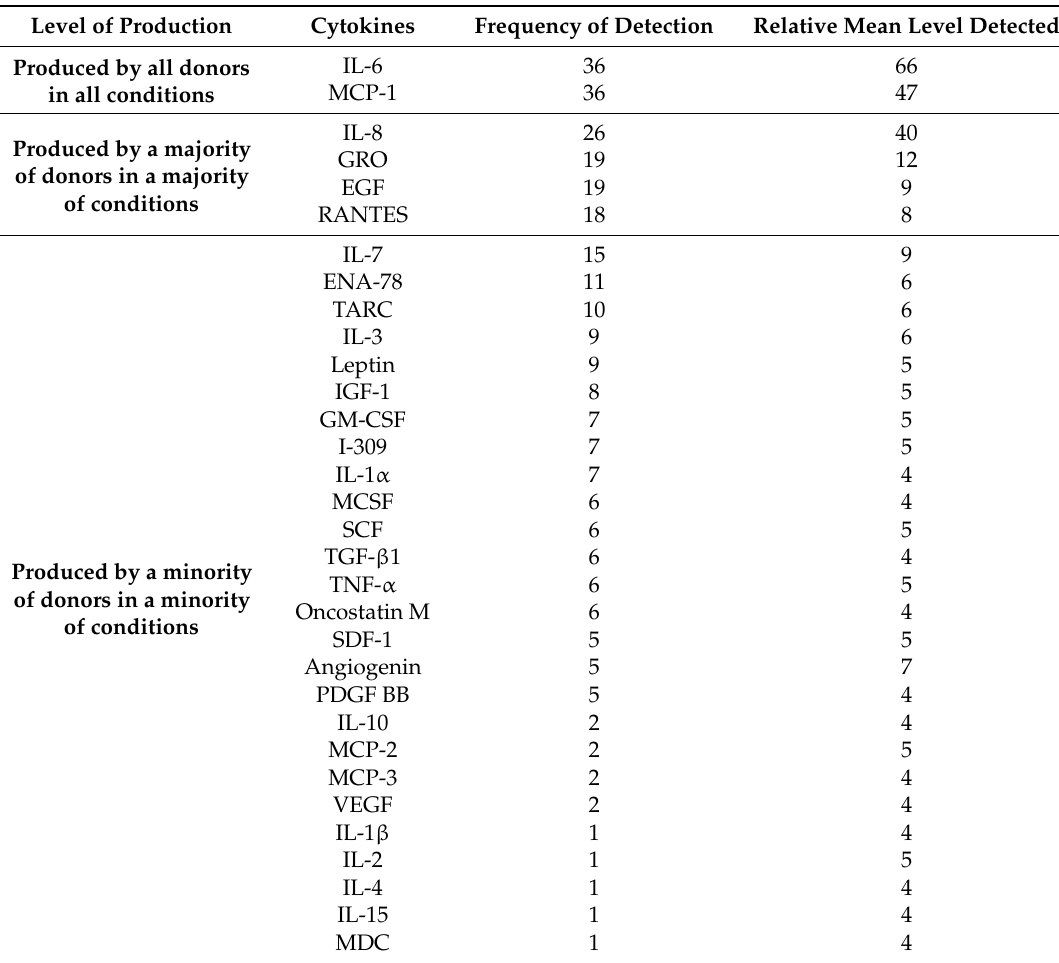
Table 1. Cytokine array inflammatory mediator screening. Values express the average ( n = 3) level of secretion (arbitrary units) for each mediator normalized with internal positive controls and an internal negative control. Frequency represents the number of conditions where cytokines could be